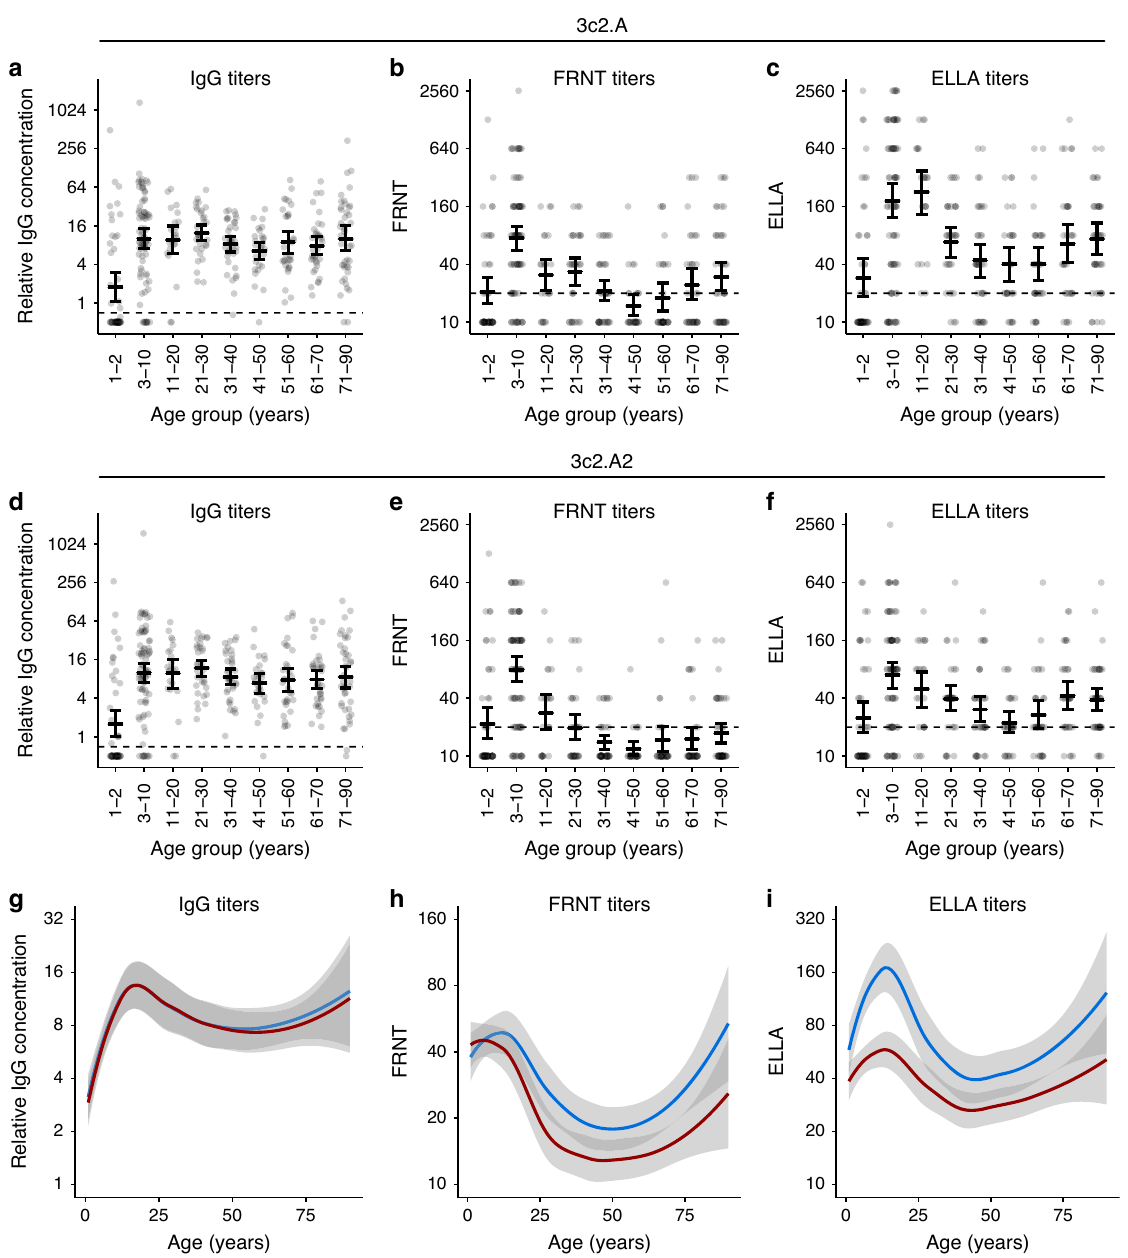
Fig. 1 Antibody titers to contemporary H3N2 viruses in serum collected prior to the 2017 – 2018 season. ELISAs were completed to quantify the levels of 3c2.A ( a ) and 3c2.A2 ( d ) HA-speci fi c IgG in serum from different aged humans. FRNTs were completed to quantify the levels of 3c2.A ( b ) and 3c2.A2 ( e ) neutralizing antibodies in serum from different aged humans. ELLAs were completed with viruses that had 3c2.A NA ( c ) and 3c2.A2 NA ( f ) to quantify NA- speci fi c inhibitory antibodies in serum from different aged humans. For ( a – f ), the geometric mean titers are shown as cross bars and 95% con fi dence intervals as error bars. g – i Data from panels ( a – f ) are summarized. Lines (blue = 3c2.A; red = 3c2.A2) are Loess curves showing smoothed geometric mean titers with the 95% con fi dence intervals shaded. Dashed lines in ( a – f ) represent the limit of detection for each